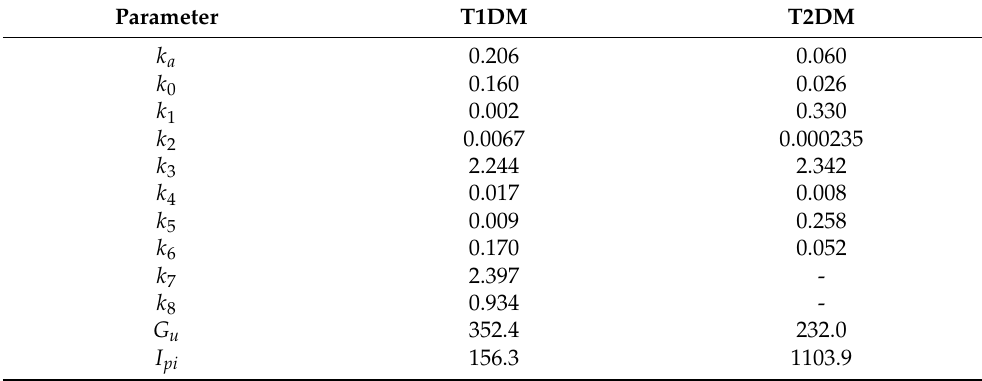
Table 1. Parameters reported in